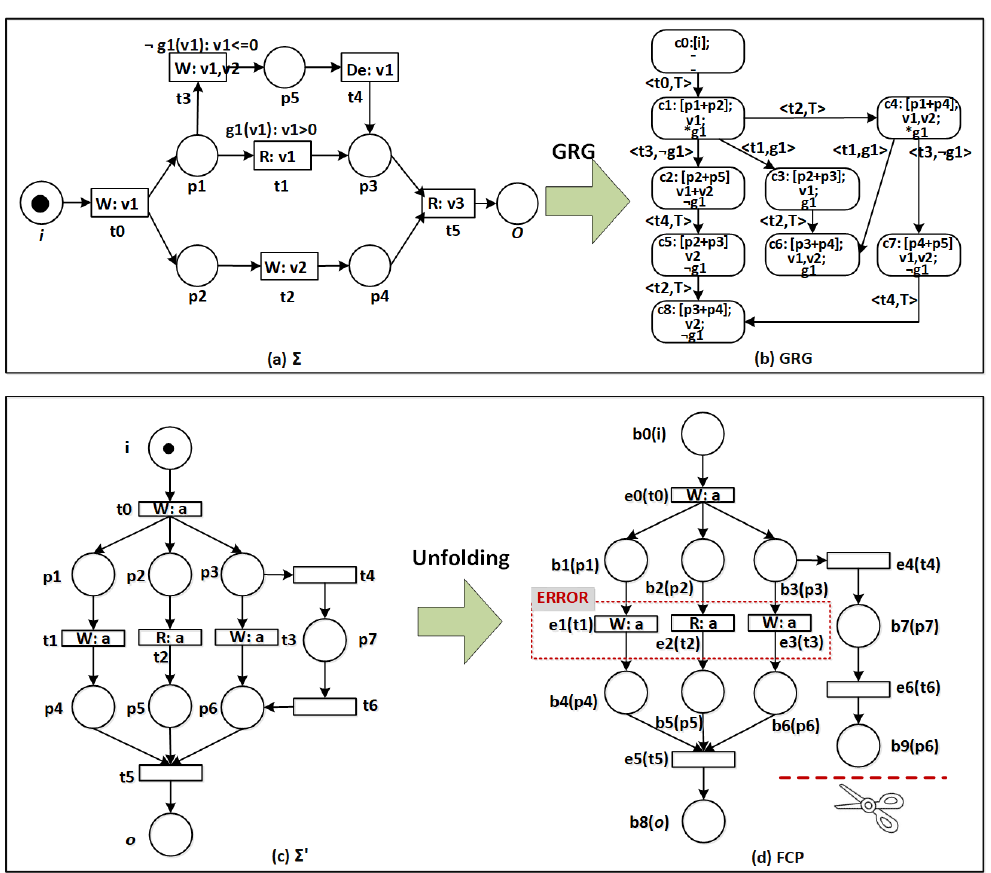
Figure 2. ( a ) A WFD-net Σ ; ( b ) the guard-driven reachability graph (GRG) of Σ ; ( c ) a PD-net Σ (cid:48) ; ( d ) the unfolding FCP of Σ (cid:48)